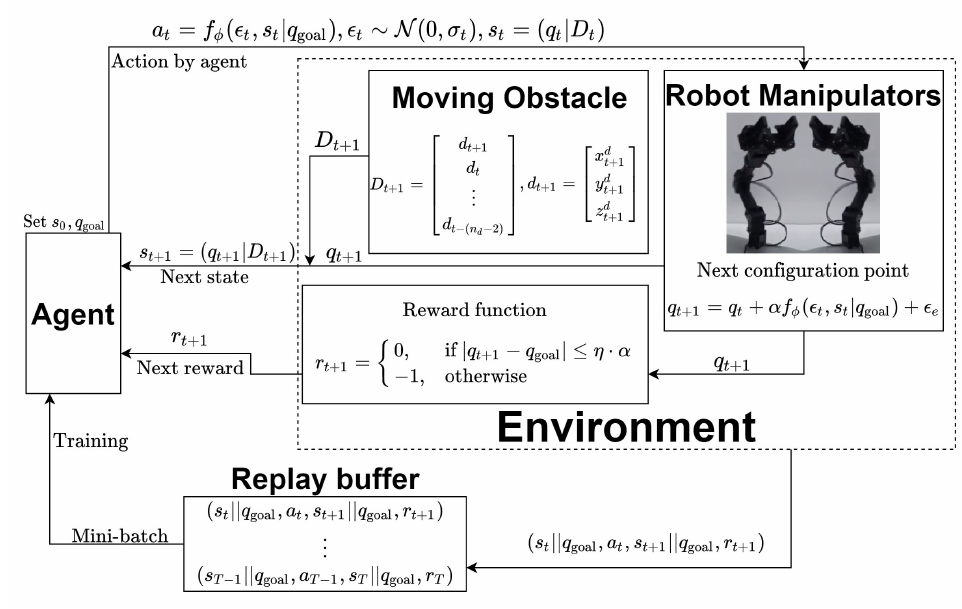
Figure 1. Multi-arm manipulator MDP considering periodically moving obstacle